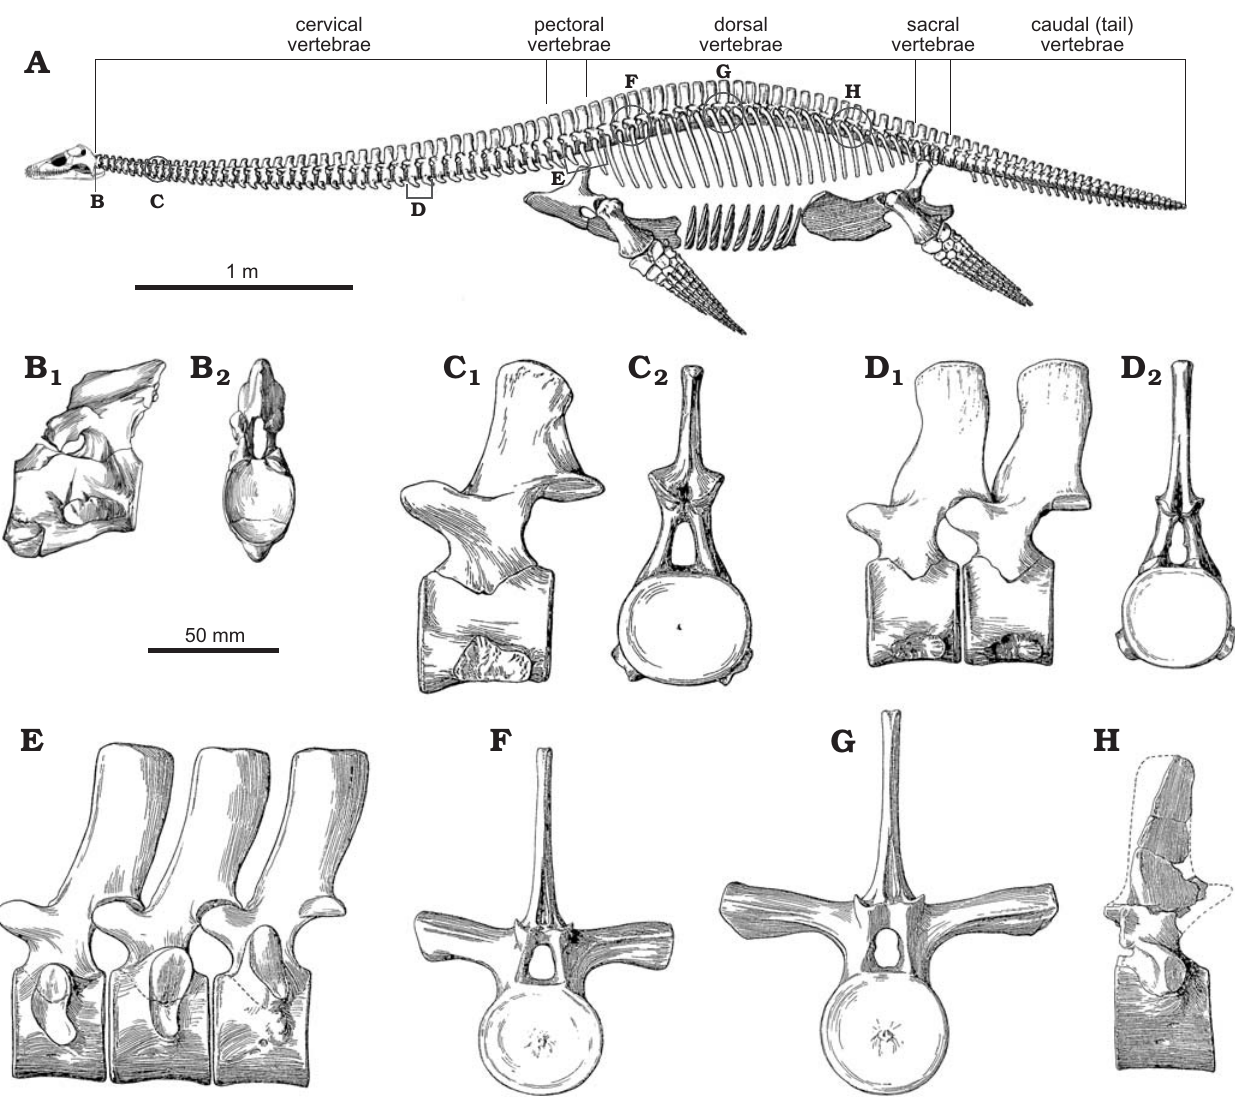
Fig. 6. Skeletal reconstruction and vertebrae of plesiosaur Muraenosaurus from the Oxford Clay Formation, Callovian-Oxfordian near Peterborough, UK. A . Skeleton showing regions of the vertebral column and approximate locations of illustrated vertebrae (B–H). B . Atlas-axis complex in left lateral (B 1 ) and anterior (B 2 ) views. C . Anterior cervical vertebrae in left lateral (C 1 ) and posterior (C 2 ) views. D . Posterior cervical vertebrae (possibly C34 and C35) in left lateral (D 1 ) and posterior (D 2 ) views. E . The last two pectoral and first dorsal vertebrae in left lateral view. F . Anterior dorsal vertebra in anterior view. G . Mid-dorsal vertebra in anterior view. H . Posterior dorsal vertebra in left lateral view. Note: the skeletal reconstruction is inaccurate: Andrews (1910) indicates the presence of 43–44 cervicals, 2–3 pectorals, 20 dorsals, 3–4 sacrals and an unknown number of caudals, whereas Brown (1981b) counted 43–44 cervicals, 3 pectorals, 19–20 dorsals, 4 sacrals and 24 caudals, however, Andrews (1910) illustrates the presence of 44 cervicals, 3 pecto- rals, 25 dorsals, 3 sacrals, and 30 caudals, thereby making both the body and the tail too long; no attempt has been made to correct this. Abbreviations: circles, indicate approximate position of figured vertebrae, as the serial position is not indicated; brackets, indicate known position of vertebrae figured. Images from: A, Andrews (1910: fig. 66) with the newly reconstructed head based on Evans (1999); B, Andrews (1910: fig. 49) with lateral view reversed from original to match skeletal reconstruction; C–H, Andrews (1910: fig.